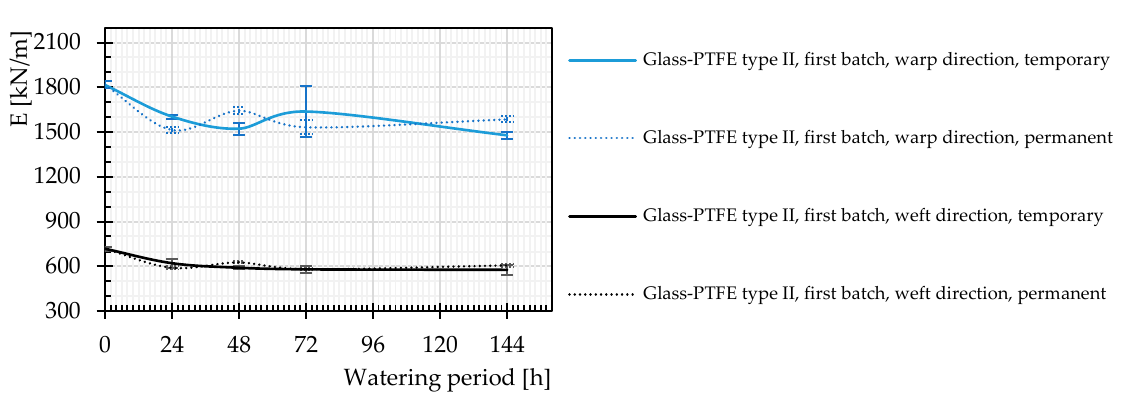
Figure 14. Comparison of stiffness, permanent and temporary changes after different periods of watering, glass-PTFE type II, first batch according to Table 3, continuous lines: temporary changes, and dashed lines: permanent changes.